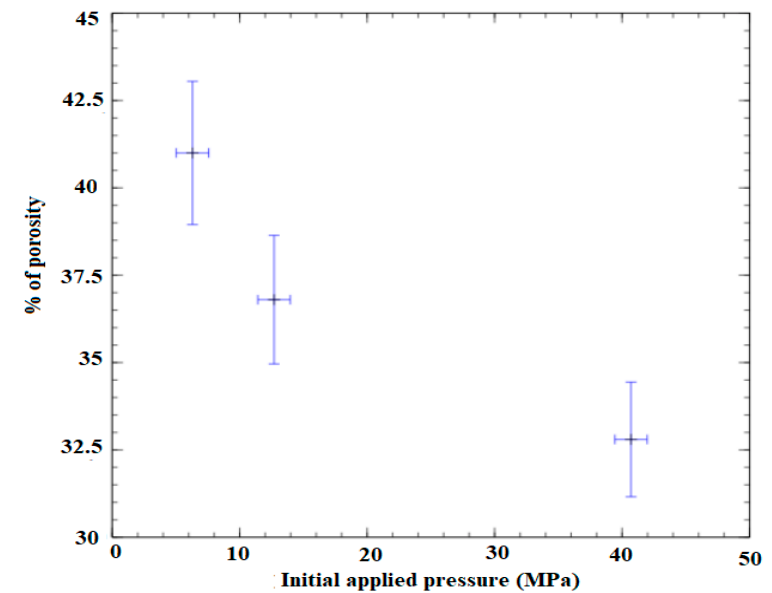
Figure 9. Variation of porosity with respect to initial applied pressure in Cu porous samples by hydrothermal sintering.